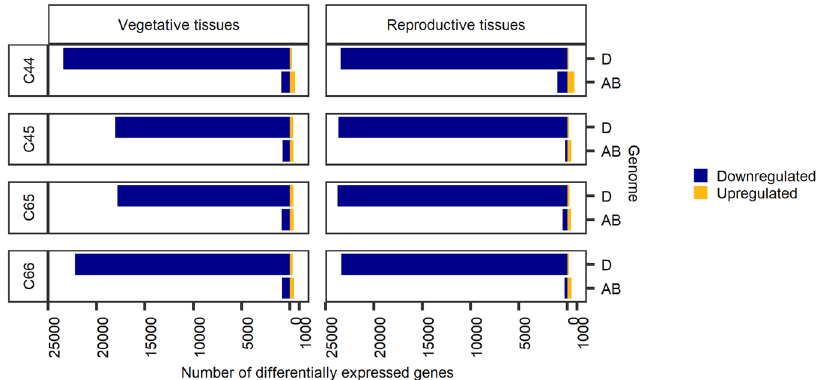
Fig. 8 Differentially expressed genes of the AB and D subgenomes of the vegetative and reproductive tissue pools upon comparison of the SHW lines (C44, C45, C65 and C66) with their parents. The blue bars represent the number of downregulated genes and the yellow bars represent the number of